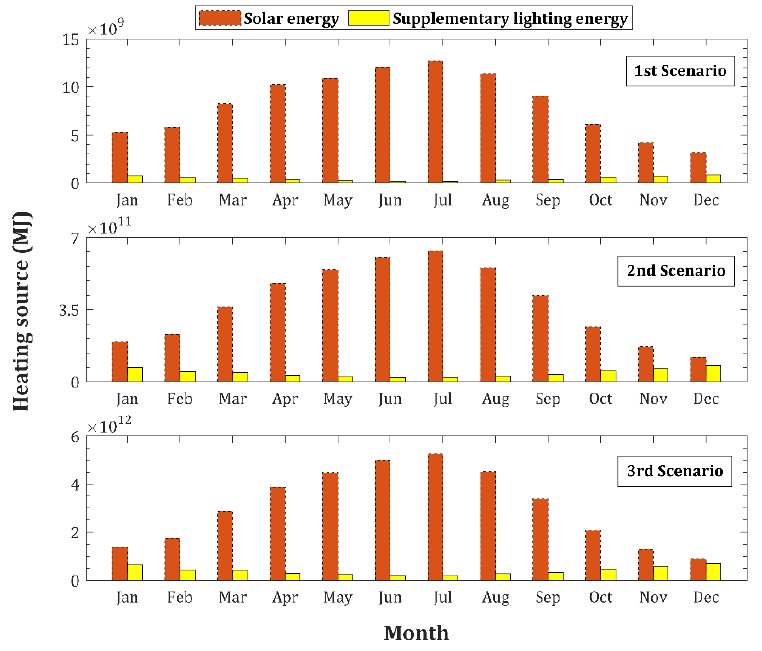
Figure 12. Monthly magnitude of heating sources in greenhouses.